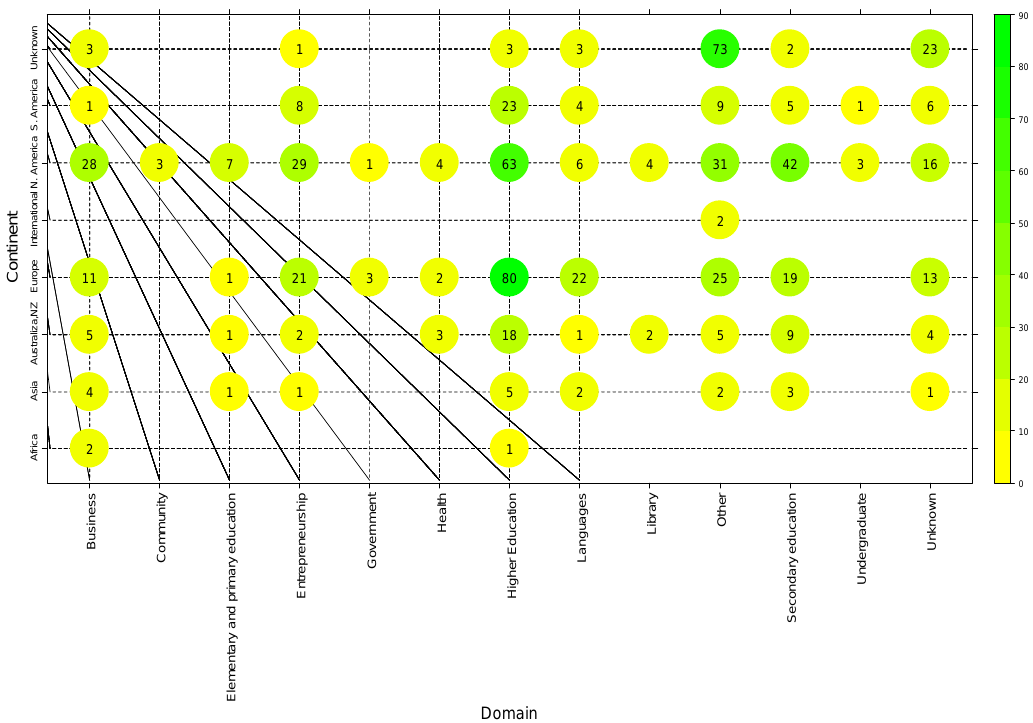
Figure 1. Summary of professional background and geographical locations of the participants in the large connected component of the course’s